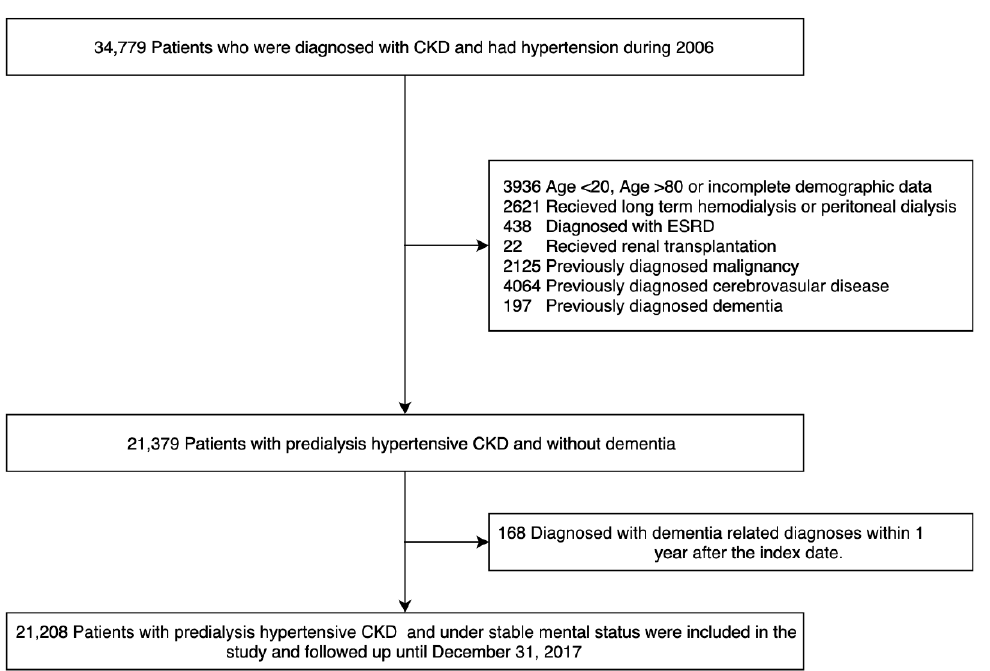
Figure 1. Schema of patient enrollment in the study.